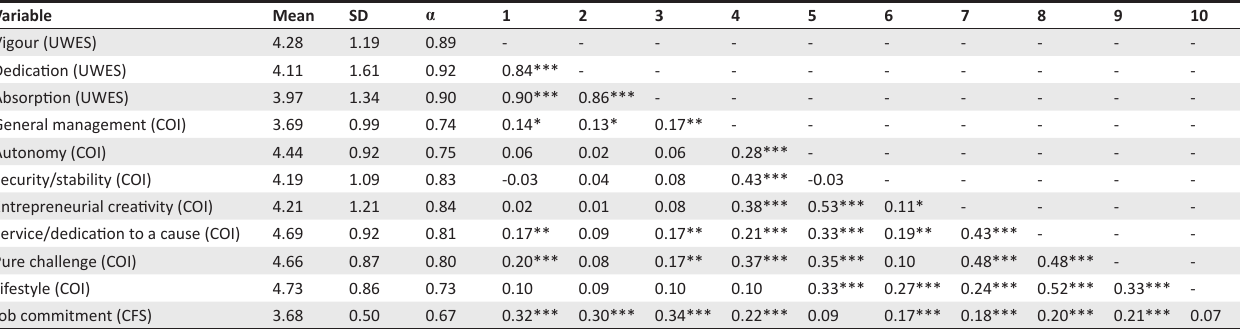
TABLE 2: Descriptive statistics and correlations.